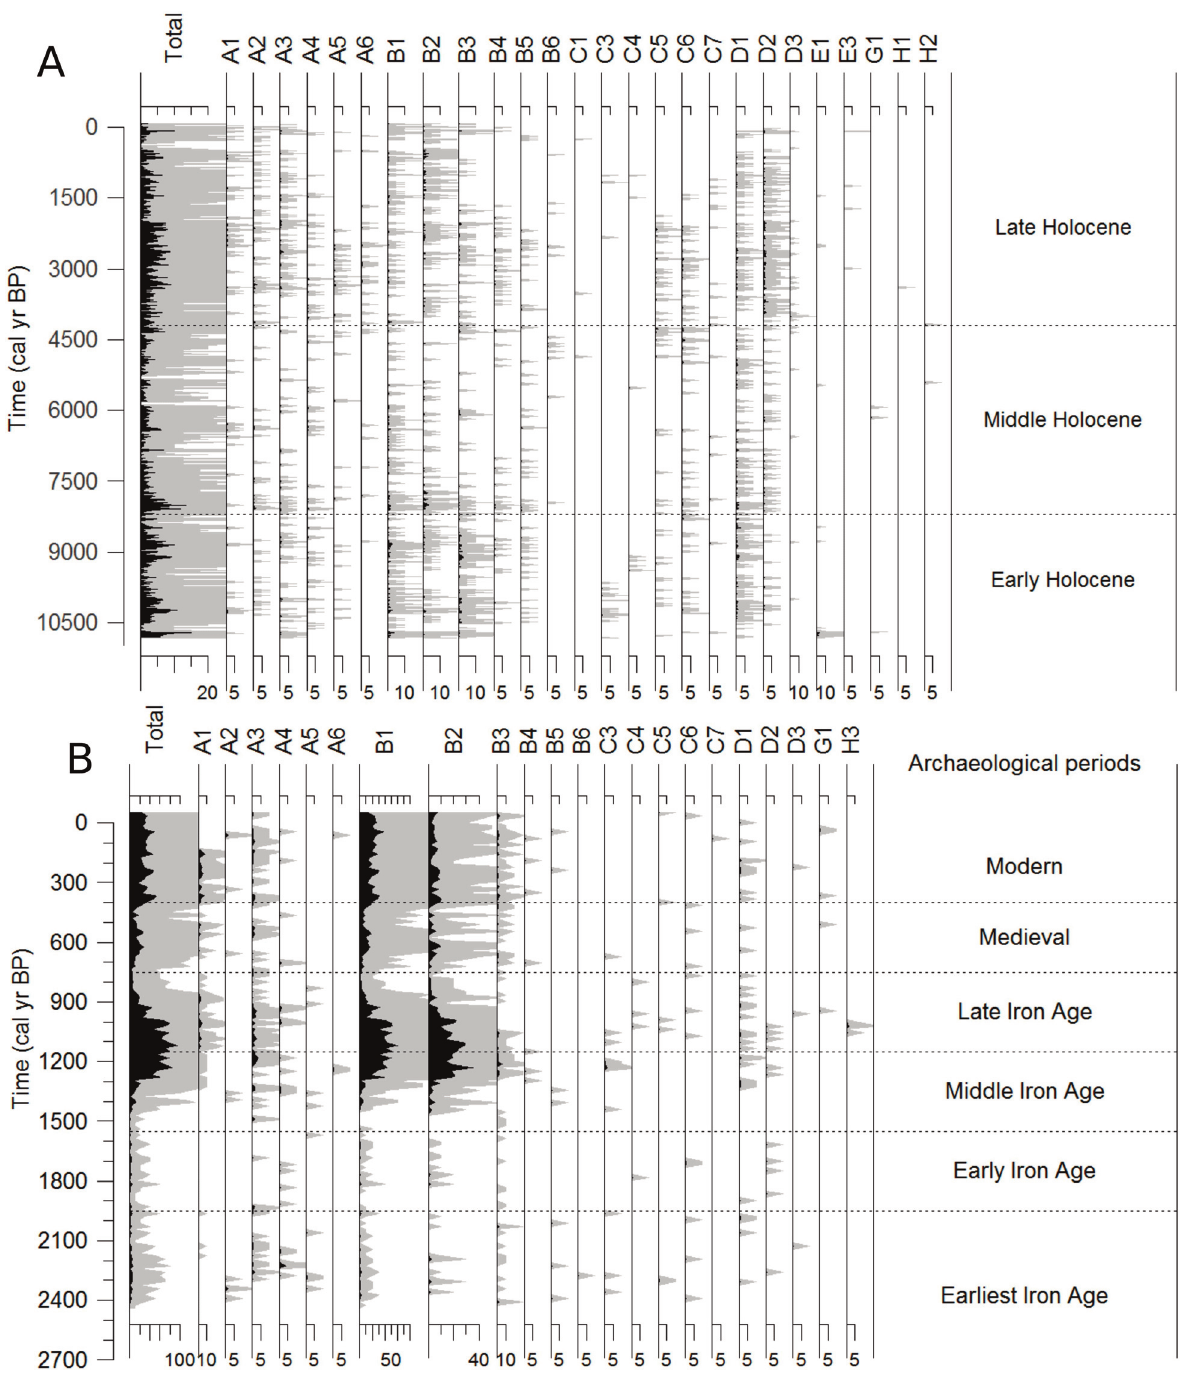
Fig. 3. Charcoal morphotypes from Lake Bricu ( A – Bricu I; B – Bricu II). X­axes: charcoal counts per sample. Charcoal morphotypes indicated by letters and related typos within the group indicated by numbers: A – polygonal charcoal (fuel: wood, herbaceous material, leaves), B – ortho­angular polygons and polyhedra (blocky shaped) (fuel: wood, Poaceae leaves, grass ), C – long and complex (fuel: conifer needles, twigs, roots, leaf stems and veins), D – long and simple (fuel: leaves, wood), E – spheroidal (fuel: seeds, sap), G – glassy (fuel: seeds, sap, resin). We defined one more group specifically for the Lake Bricu case: H – does not correspond to any other group (fuel: